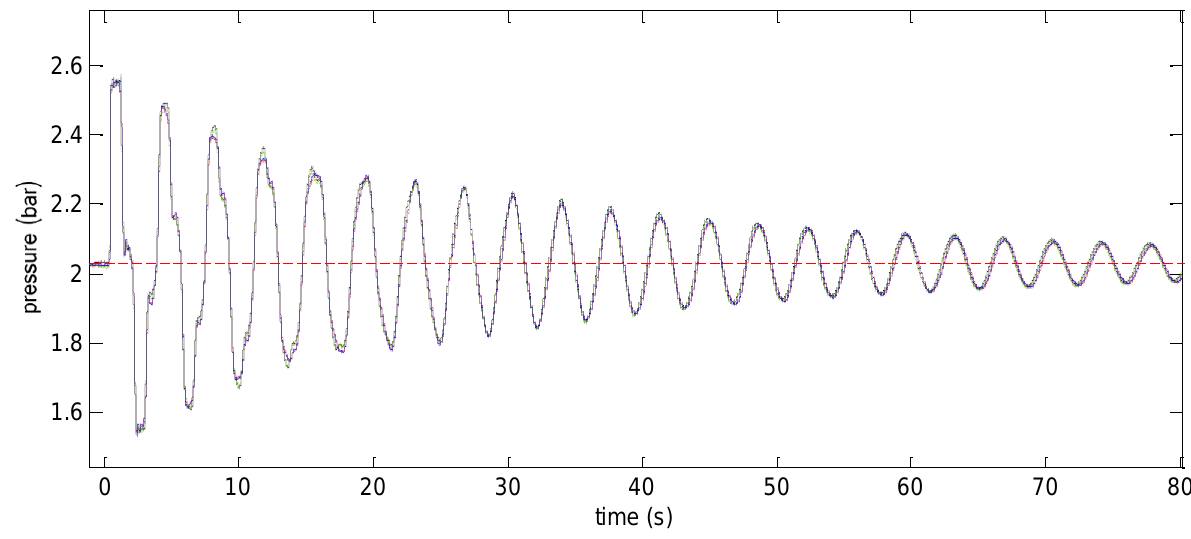
located at point 5 for four repeated experiments. 5